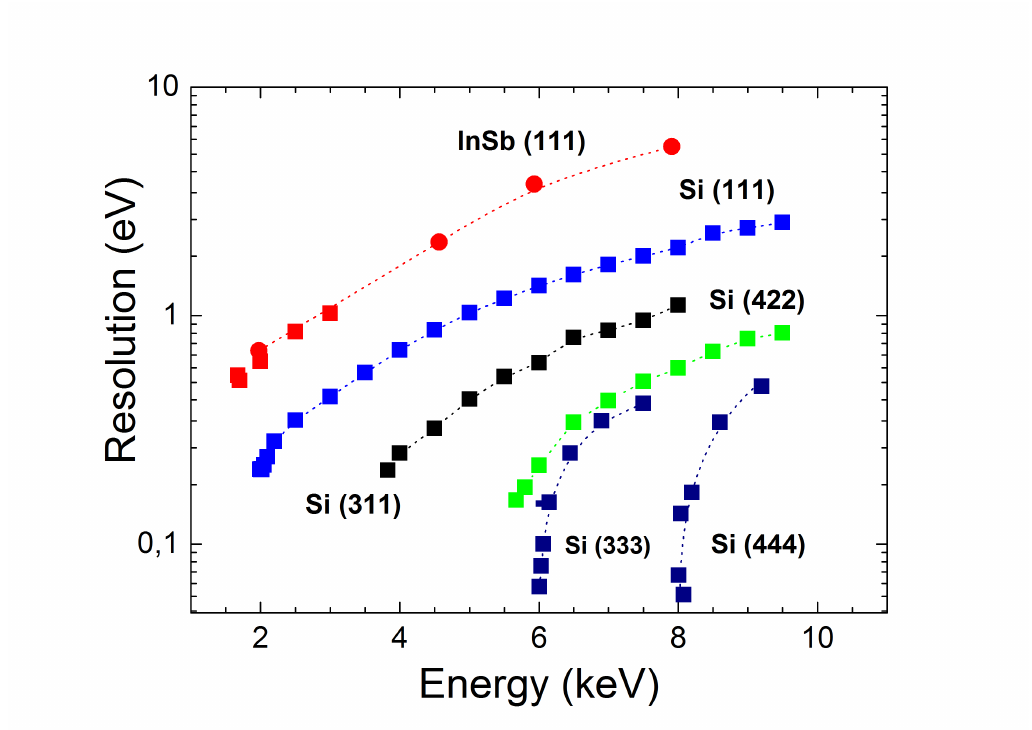
Figure 4: Energy resolution of the KMC-1 beamline for the different